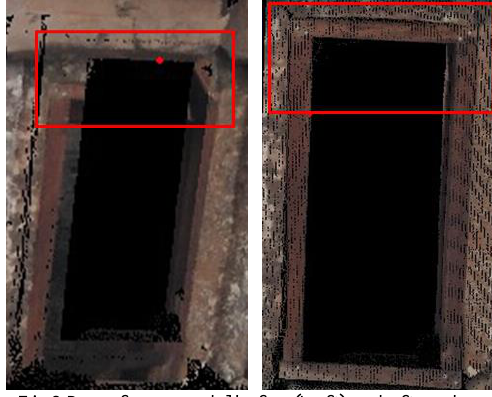
Fig.8 Door frame model before(Left) and after when mapping the texture data(Right ）